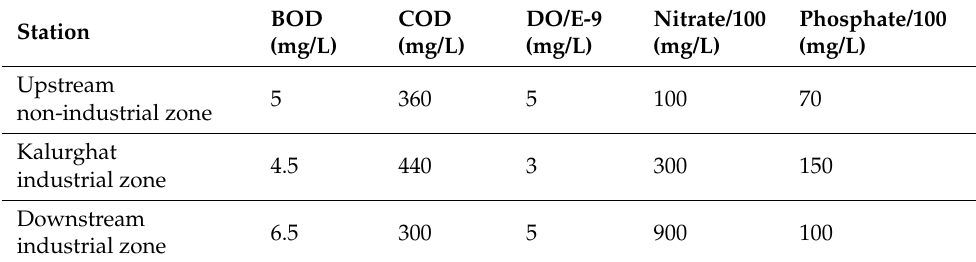
Table 4. Distribution of chemical substances in three different industrial